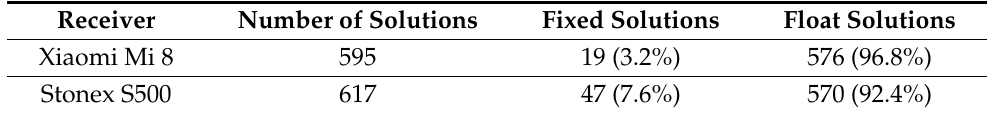
Table 1. Test 1: Solution